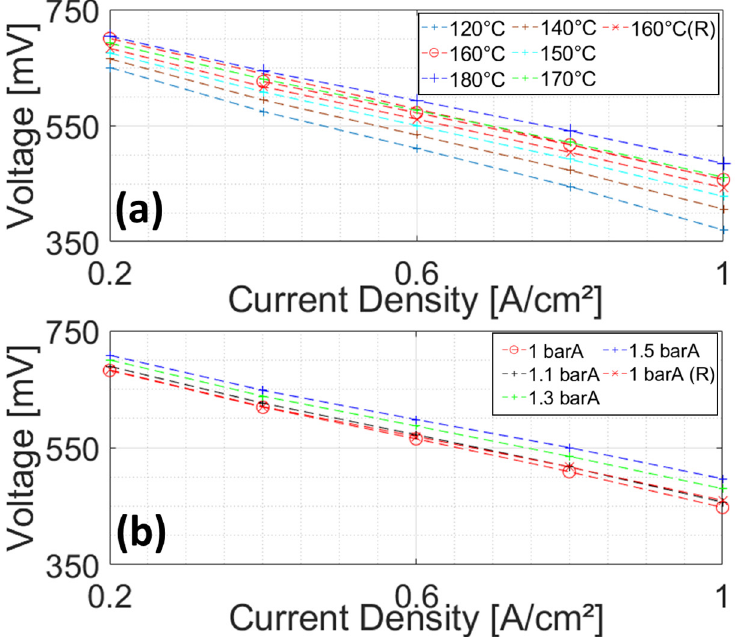
Figure 8. ( a ) Voltages as a function of current at 1.1 barA and for different temperatures (without 155 °C and 165 °C for clarity); ( b ) Voltages as a function of current density at 160 °C and for different pressures. (R) is annotated to indicate the return to the initial operating condition.